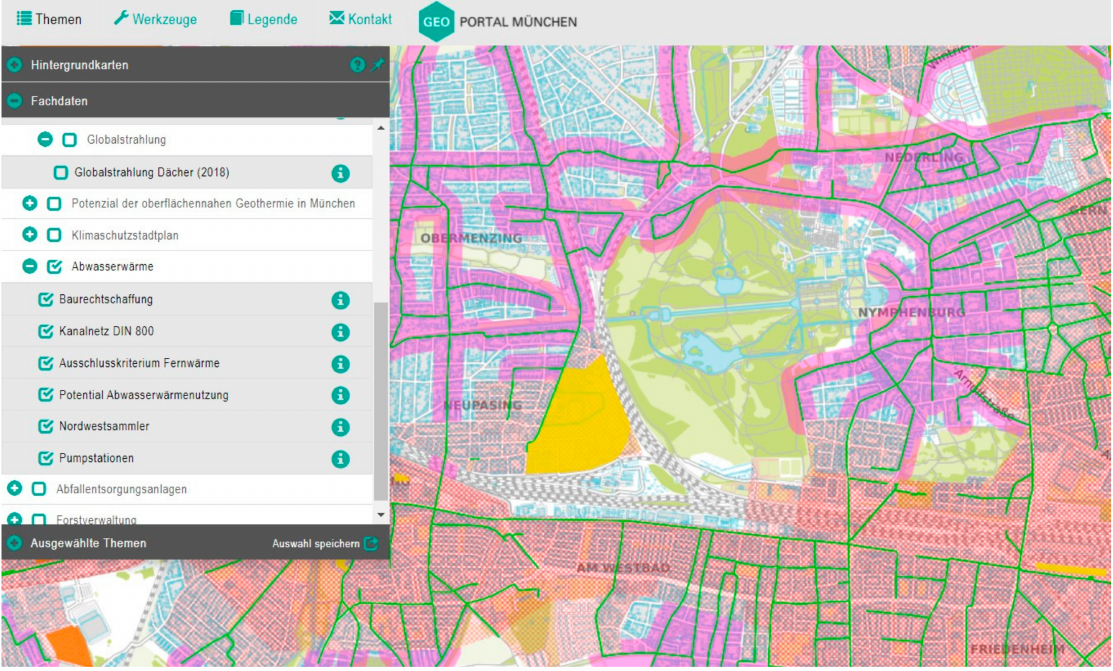
Figure 14. Wastewater heat in Munich. Source: own study based on